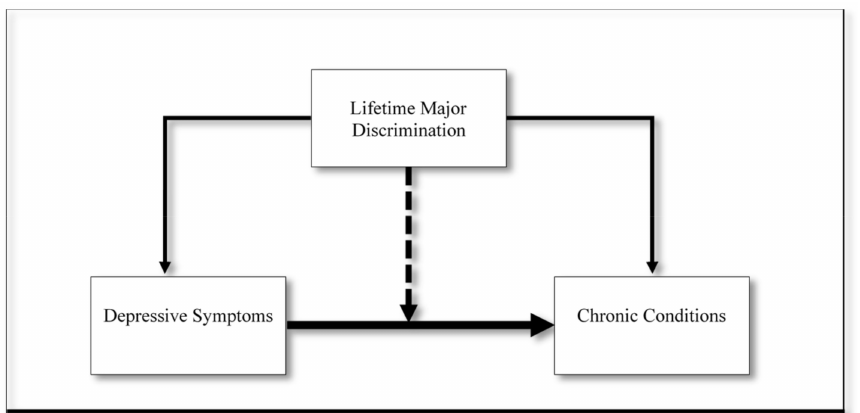
Figure 1. Conceptual model examining the moderating role of lifetime major discrimination on the association between depressive symptoms and chronic conditions among Black